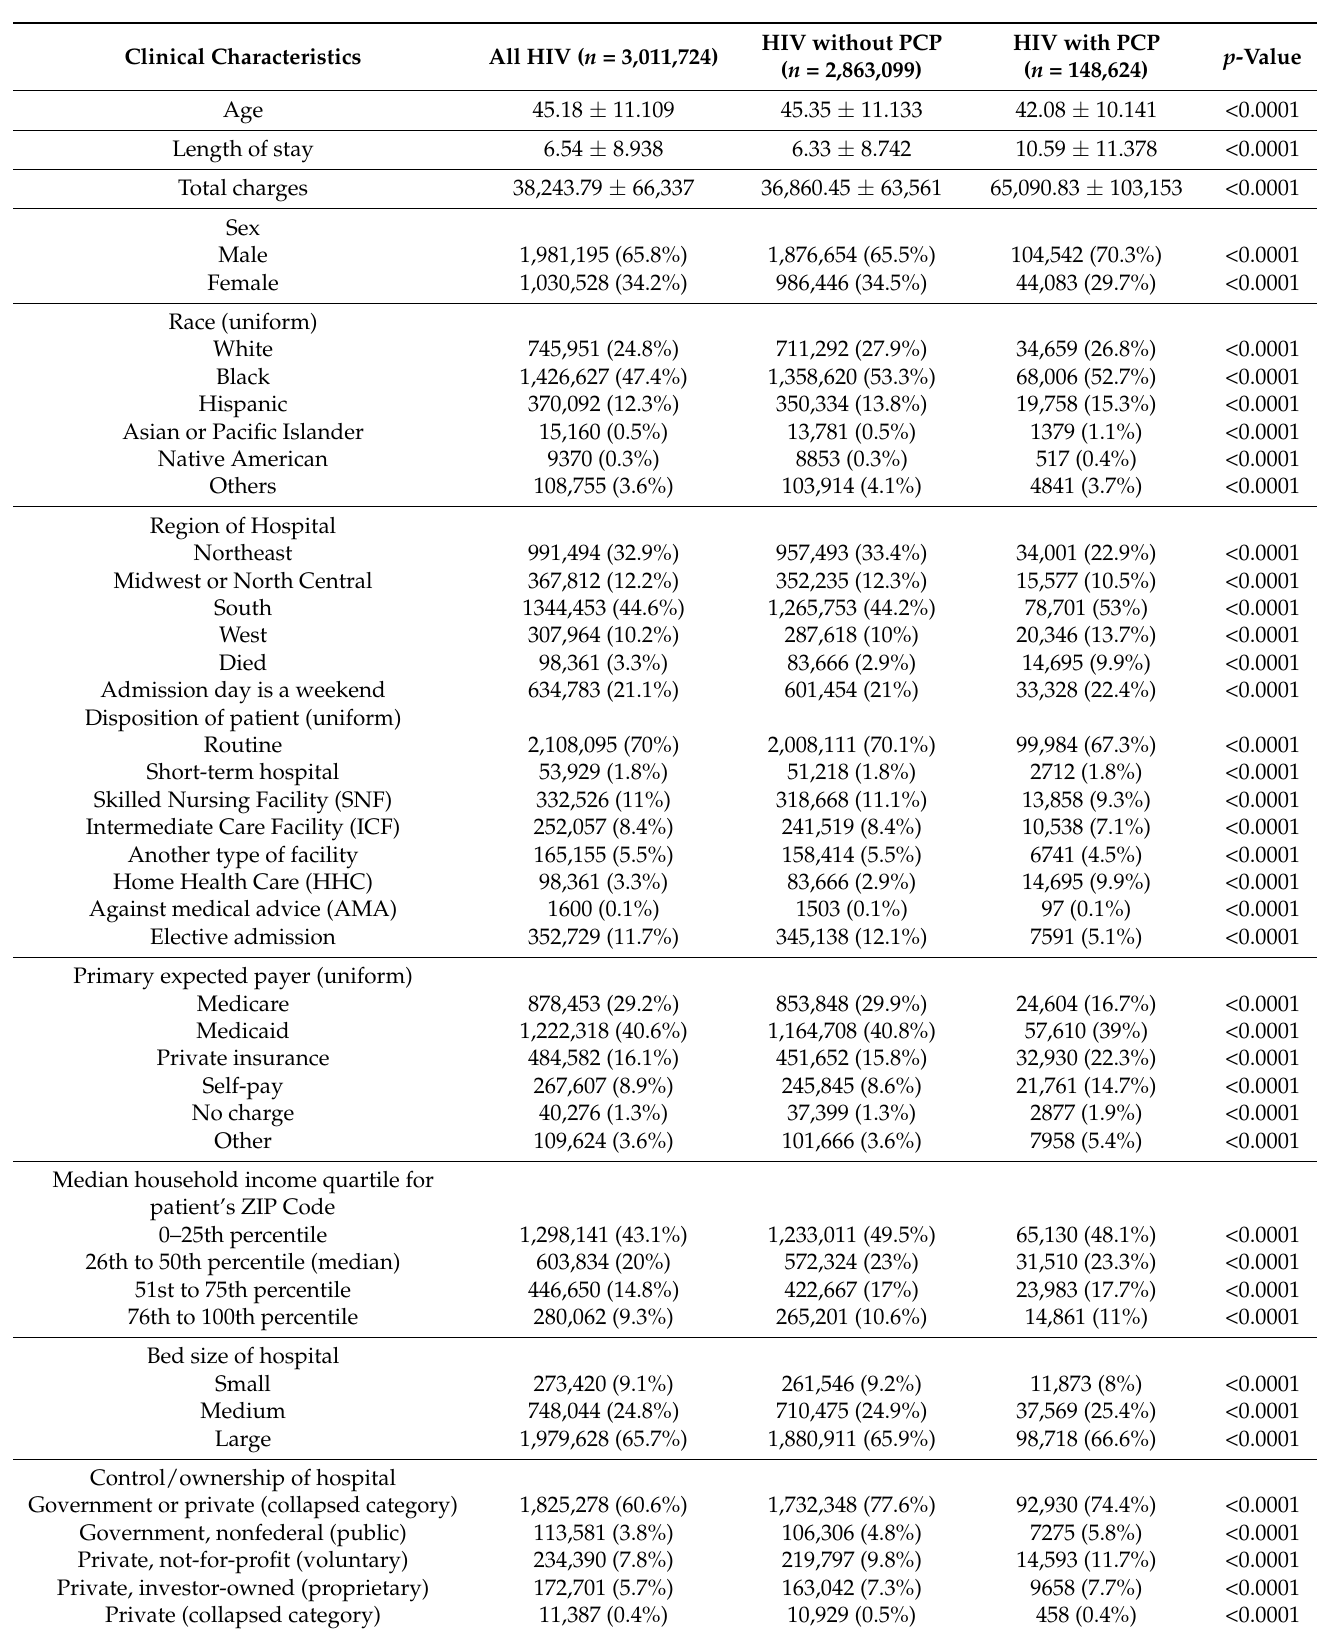
Table 1. Demographic characteristics of HIV hospitalizations with and without Pneumocystis pneu- monia